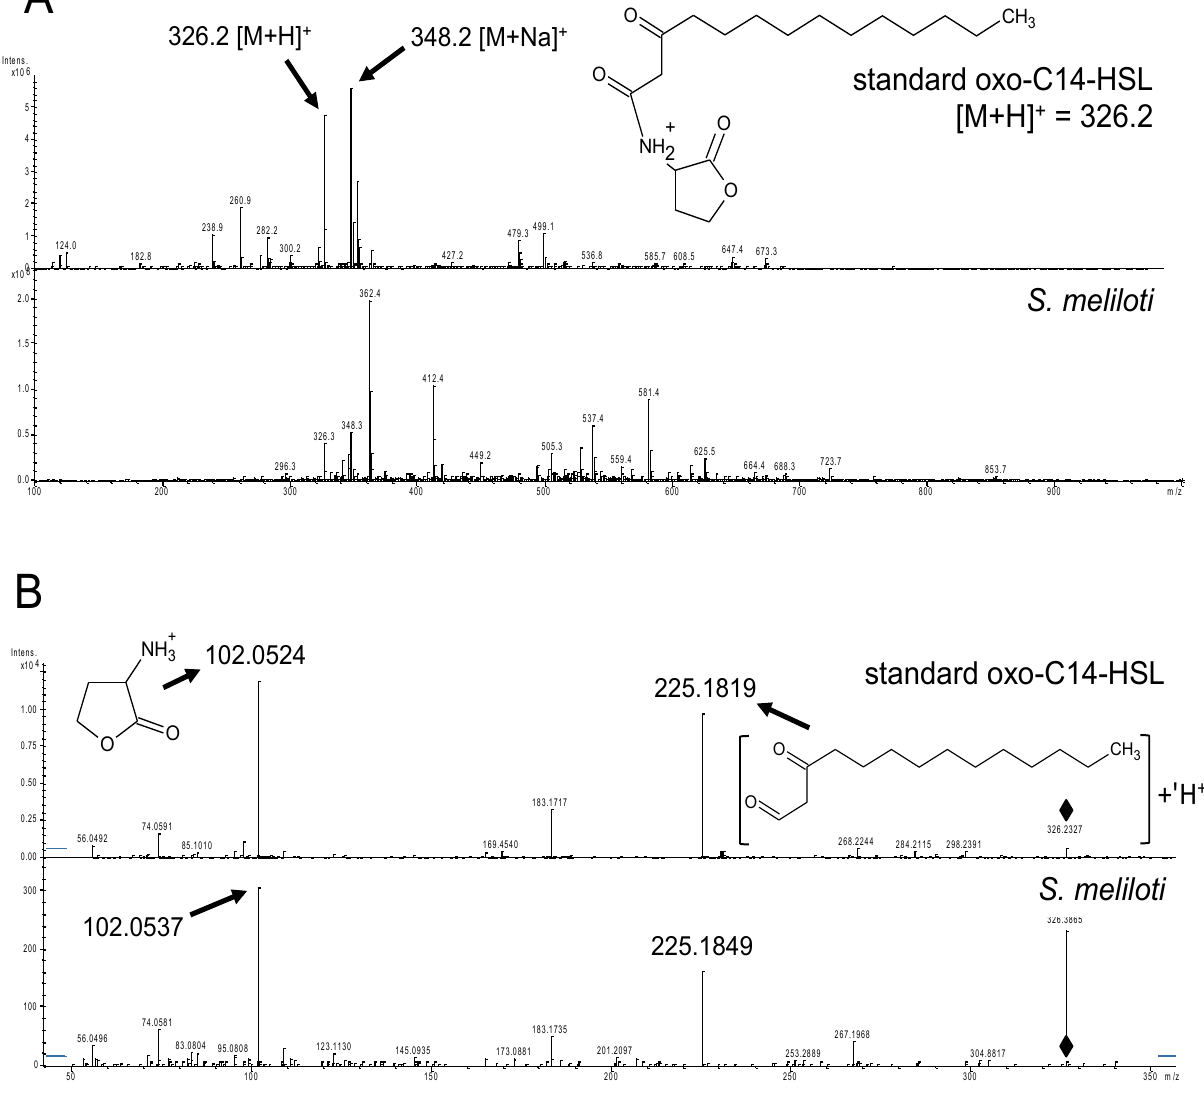
Figure 1. Verification of N- acyl-homoserine lactone (AHL) production in S. meliloti Rm2011. HPLC samples were screened in the positive ion mode from m/z 50 to 400. ( A ) The MS of standard oxo-C14-HSL standard ( m / z = 326.2 [M + H] + ) shows a pattern similar to the AHL extracted from S. meliloti Rm2011 culture; ( B ) Further analysis of m / z 326.2 by MS/MS confirmed the identity of AHL extracted from S. meliloti Rm2011 culture with the standard oxo-C14-HSL. The diagnostic fragment ions m / z 102.0524 and 102.0537 are indicative for the presence of the lactone ring. The highlighted m / z values represent diagnostic fragment ions. Diamonds mark the pseudomolecular ions used as precursors for MS/MS